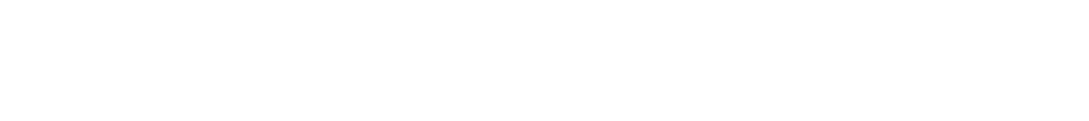
Frontiers in Neurology |